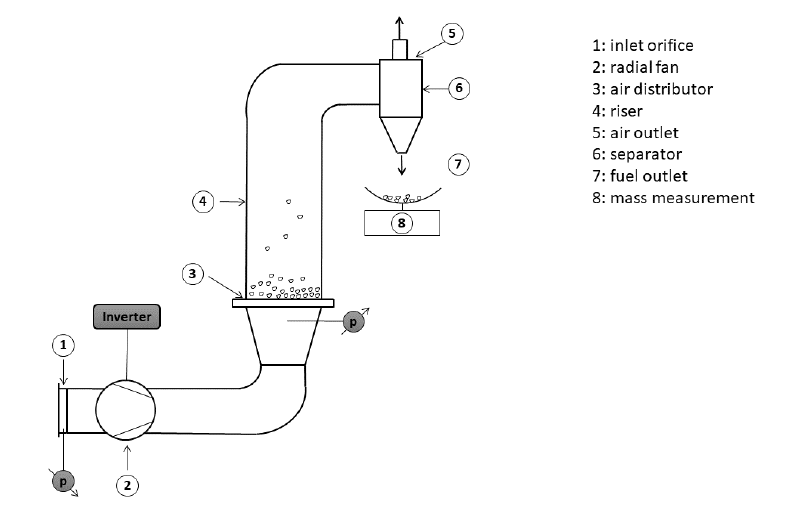
Figure 3. Schematic of the experimental setup of the active particle entrainment tests.